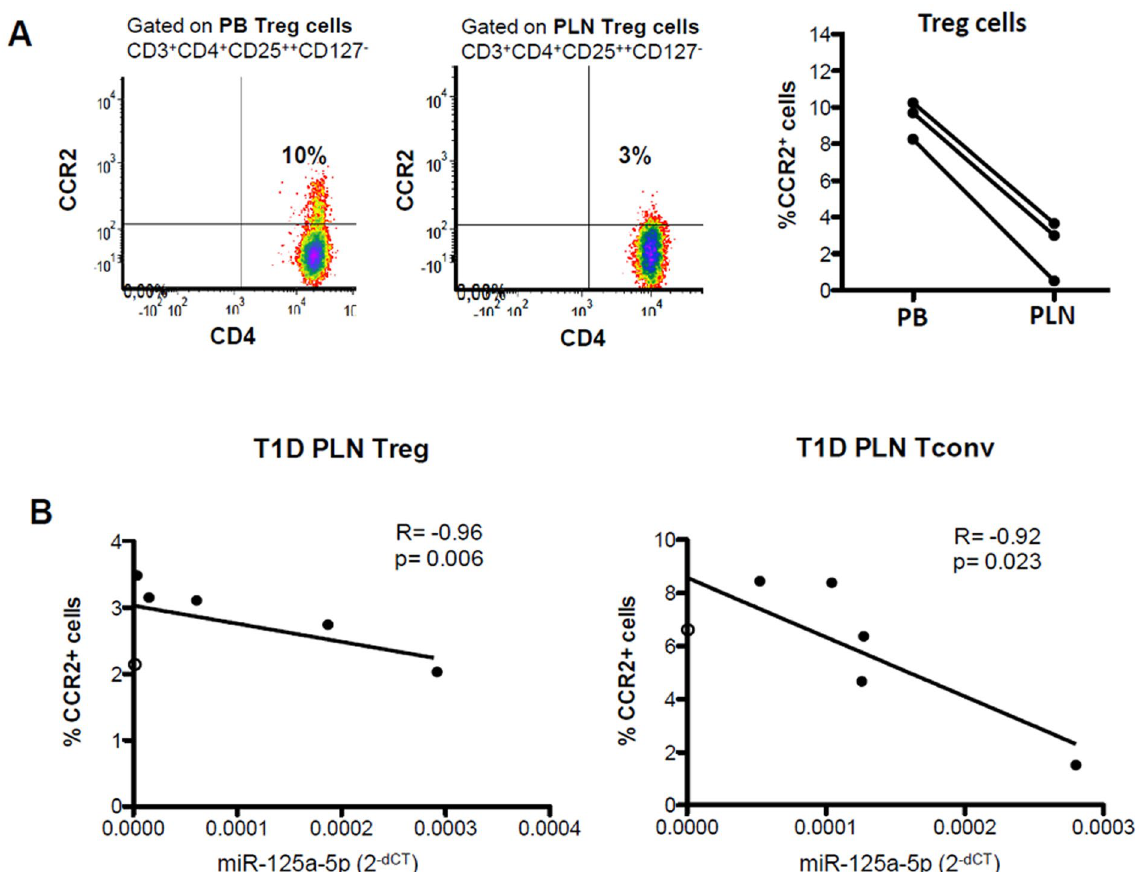
Figure 4. ( A ) Representative flow cytometry dot plot showing CCR2 expression on Treg cells in peripheral blood (PB) and pancreatic lymph nodes (PLN) of a patient with T1D (left panel) and data collected in 3 patients with T1D (right panel). (B) Correlation analysis between percentages of CCR2 + cells in Treg cells (left panel) and Tconv cells (right panel) measured by flow cytometry and miR-125a-5p expression values measured as 2 − dCT . Spearman R test was